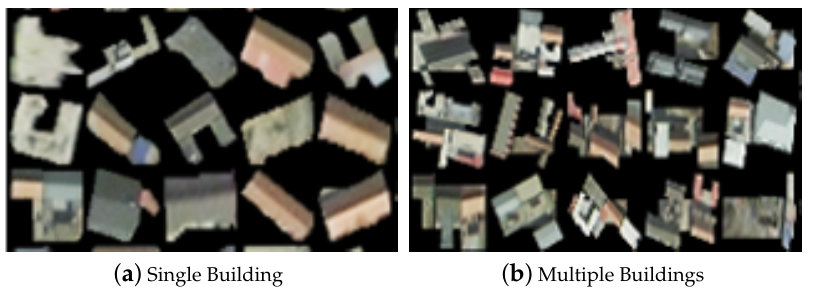
Figure 13. Different